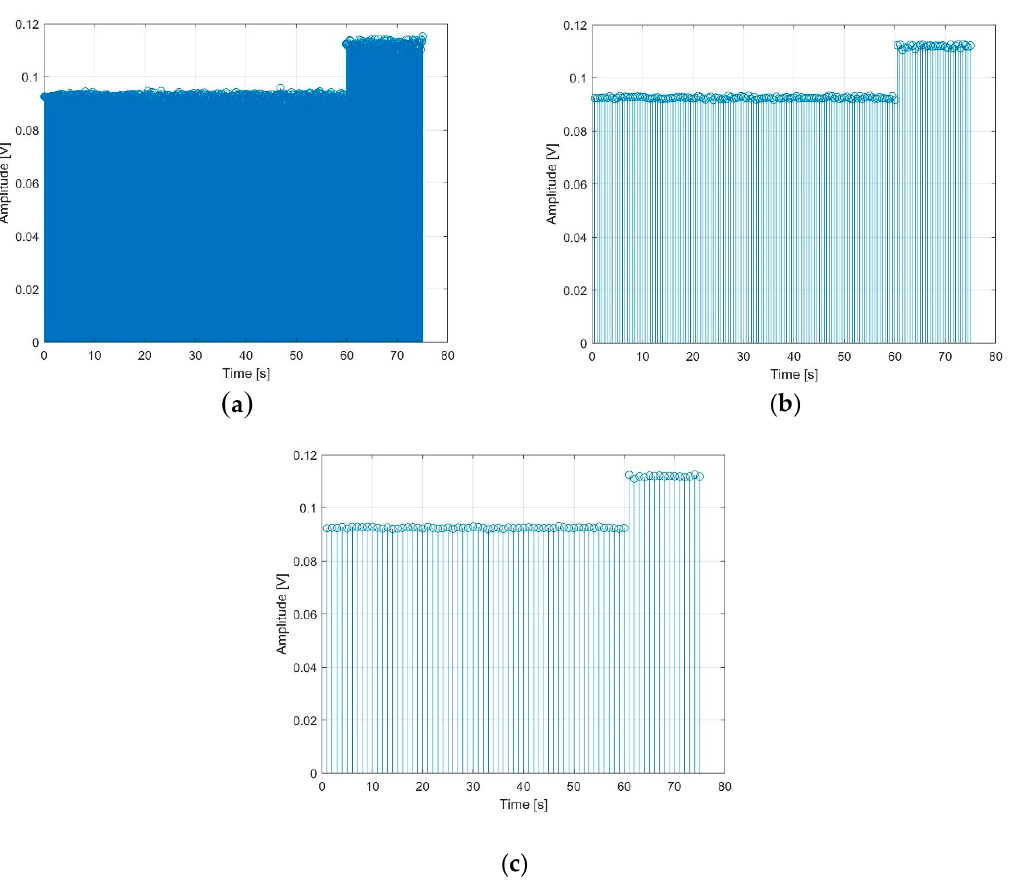
Figure 12. FFT analysis results of the electromagnetic force (EMF) signal (@70 Hz): ( a ) N = 100, ( b ) N = 500, and ( c ) N = 1000.